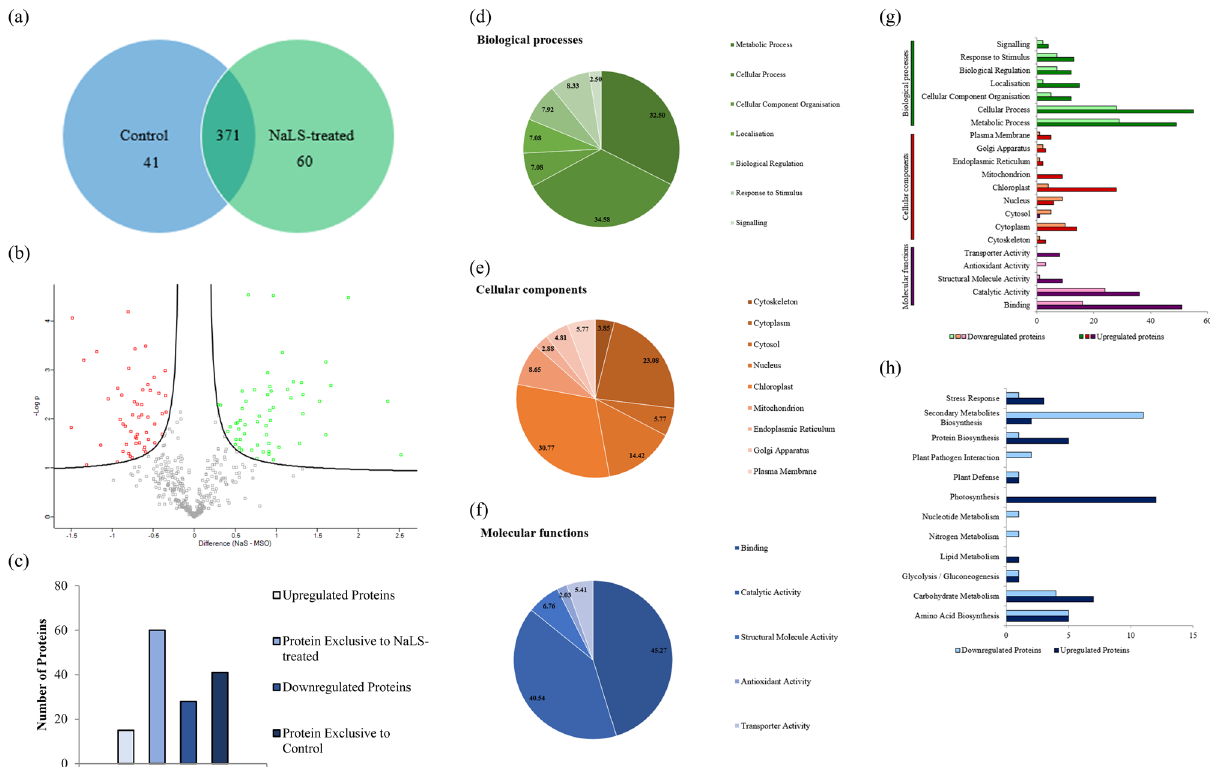
Figure 2. Comparative proteomic analysis between MSO and NaLS-treated rice. ( a ) Venn diagram of the total protein obtained from MSO and NaLS-treated rice. ( b ) Volcano plot showing up- (green squares) and downregulated (red squares) proteins of the NaLS-treated rice. ( c ) The total numbers of exclusive, up-regulated and down-regulated proteins in NaLS-treated rice compared to MSO. Gene ontology (GO) analysis in terms of ( d ) biological processes, ( e ) cellular components and ( f ) molecular functions of differentially expressed proteins and ( g ) their relative abundance of NaLS-treated rice. ( h ) KEGG pathway analysis of differentially expressed proteins found in NaLS-treated rice compared to Fig. S1). Score plot of two principal components with PC1 and PC2 indicated 56.2% and 19.2%, respectively, thus made the total variance for the PCA is 75.4%. Meanwhile, the loading plot of PCA (Supplementary Fig. S1)